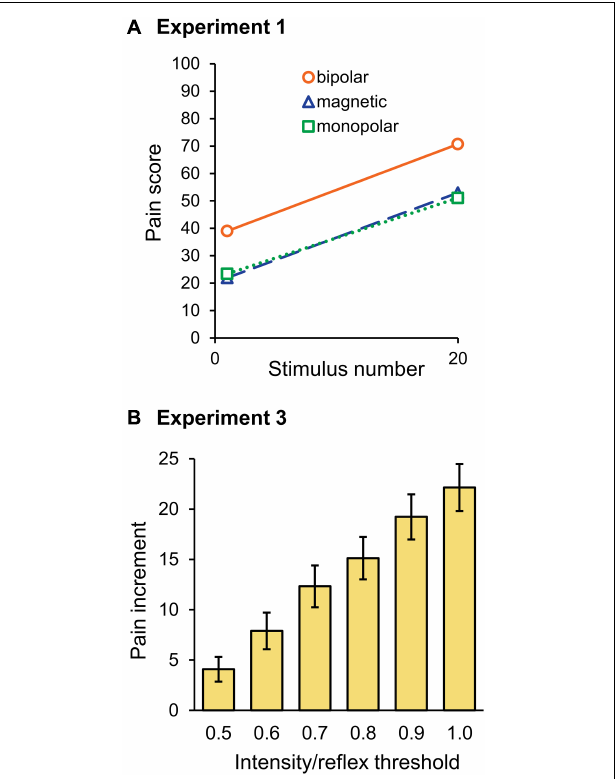
FIGURE 6 | Pain ratings. (A) Mean score of the pain rating scale for the first and last stimuli in Experiment 1. Note that the pain score for bipolar stimulation was significantly higher than for magnetic or monopolar stimulation, however, the wind-up effect was not significantly different among the three groups. (B) Mean pain score increment between the first and last stimuli in Experiment 3. With stronger stimulation intensities, the pain score increase was